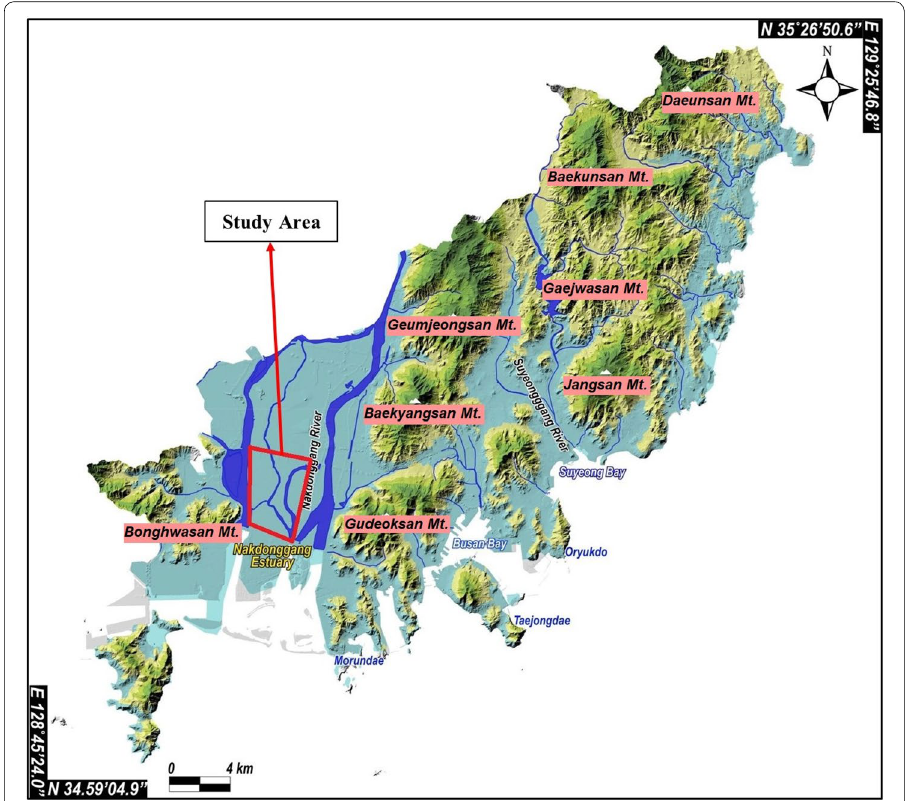
Fig. 2 Geomorphological map showing the location of mountains, rivers, bays and capes in Busan city